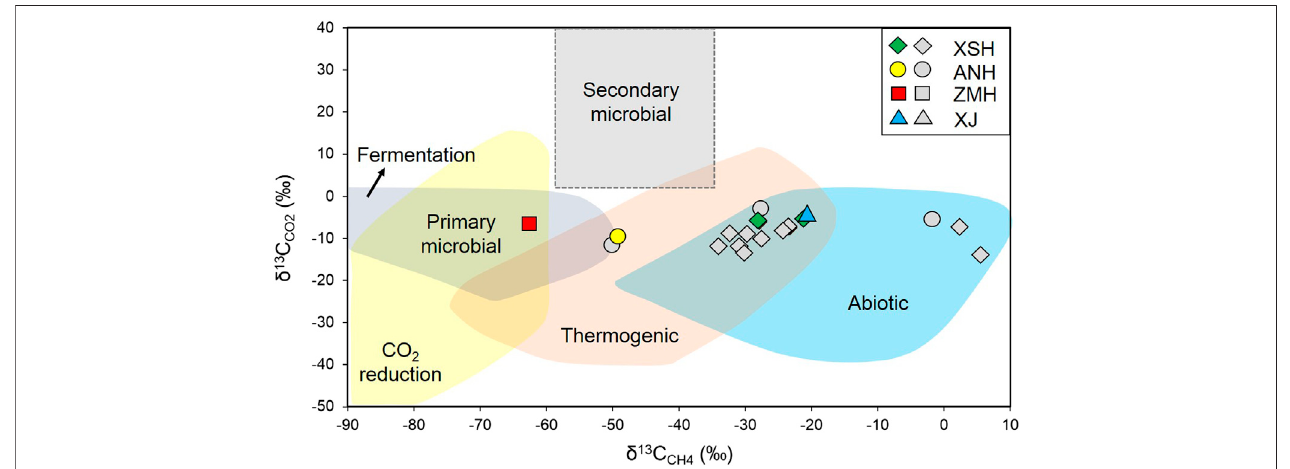
FIGURE7| Plotof δ 13 C CO2 vs . δ 13 C CH4 .Thecoloursymbolsaredatafrombubblinghot-springgasinthisstudy.Thegreysymbolsarehot-springgasdatareported in Shen et al. (2007) and Zhou et al. (2015). Modi fi ed after Milkov and Etiope (2018).